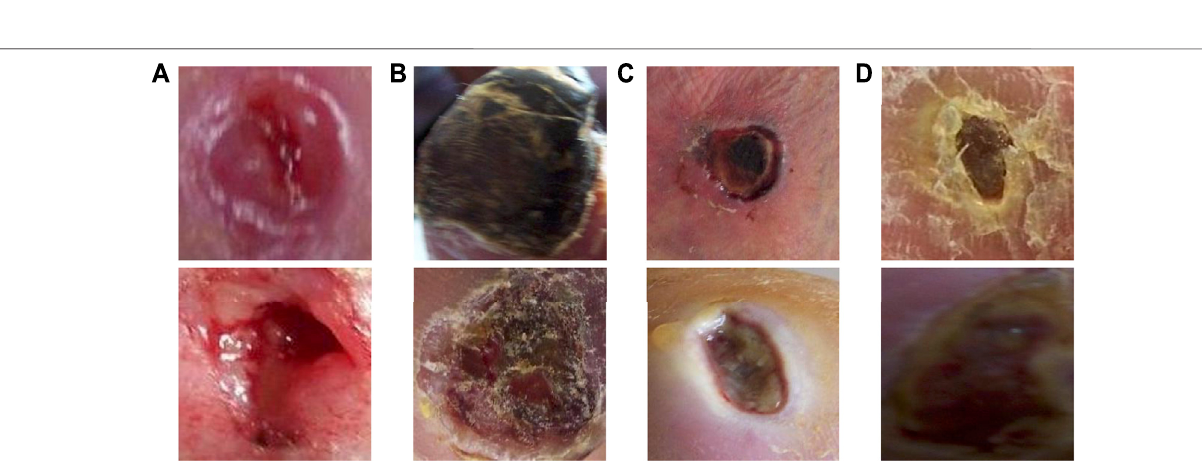
Frontiers in Bioengineering and Biotechnology |